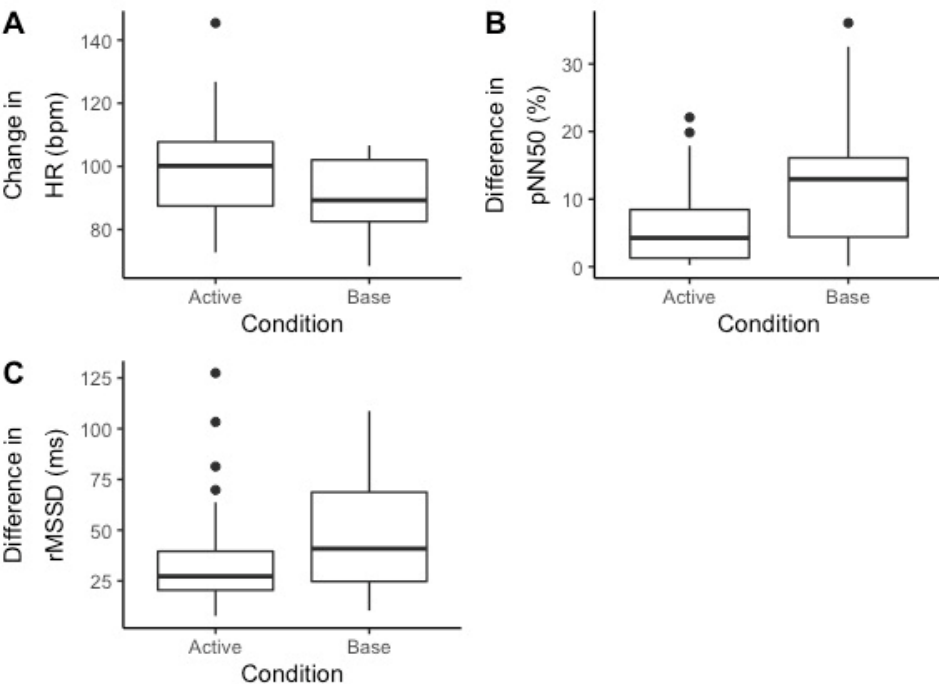
Figure 4. The difference in HR ( A ) and HRV ( B , C ) measures during Active (euthanizing) vs. base (non-euthanizing) days. Average heart rate (t (20) = 3.785, p = 0.001) was statistically significantly higher and pNN50 (t (20) = − 3.171, p = 0.005) was lower during killing. There were no significant differences in rMSSD.